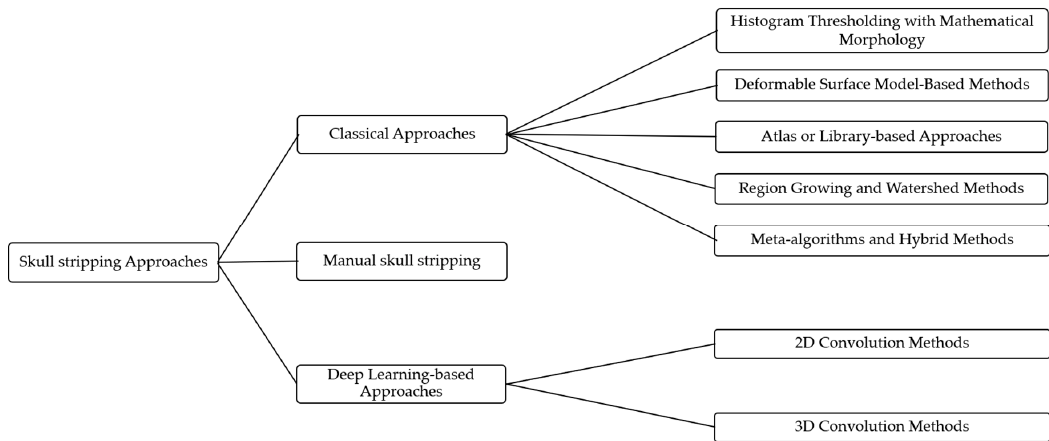
Figure 1. Skull stripping in brain MRIs. ( a ) Input 2D brain image in three orientations (coronal, axial, and sagittal), and ( b ) respective skull stripping in each image. ( c , d ) Similarly, the skull stripping in brain MRI volume (data from NFBS dataset